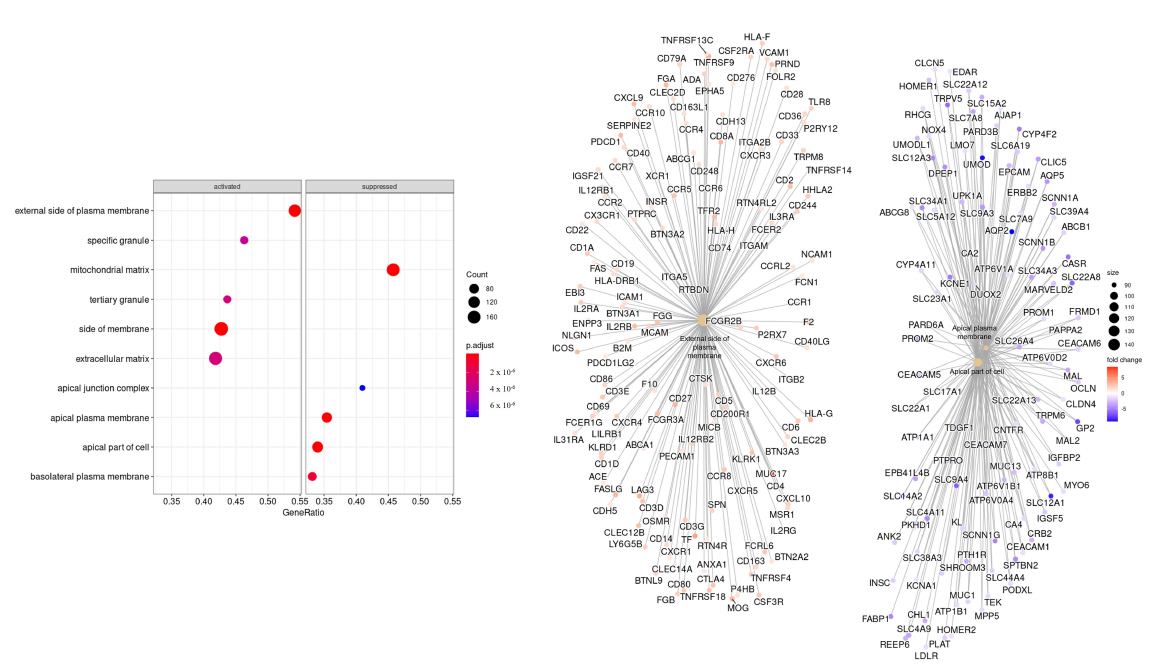
Figure 3. Gene ontology enrichment analysis regarding cellular components terms for a list of DEGs ranked by the log fold change between tumor and normal tissues. The left panel shows a dot chart with the most significant CC terms. The right panel shows a gene-concept network plot of the three most enriched terms that depicts the linkages of genes and biological concepts as a